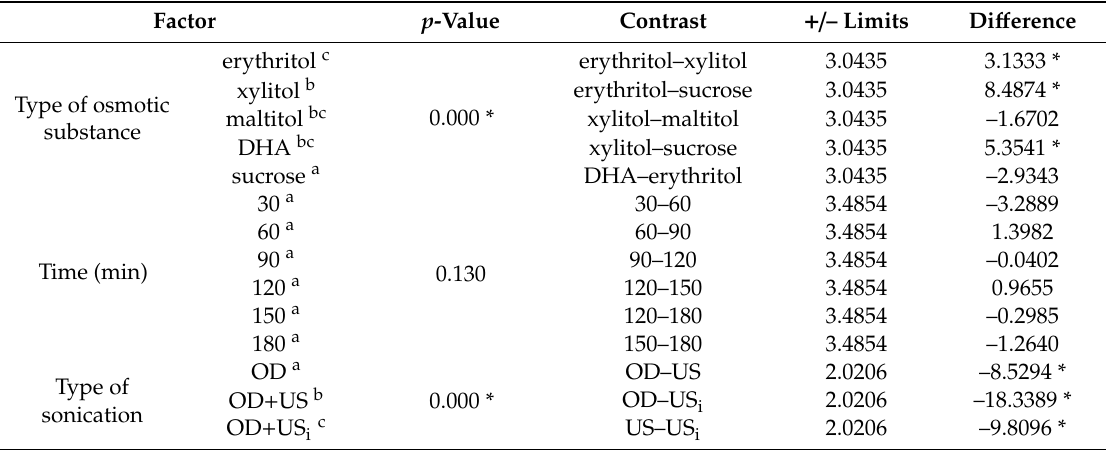
Table 13. The influence of osmotic agents and pre-treatment time on the BI parameter during OD.